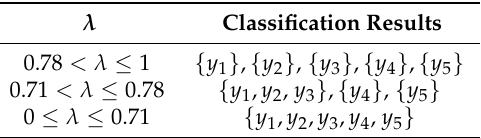
Table 4. Clustering algorithm in literature [19].